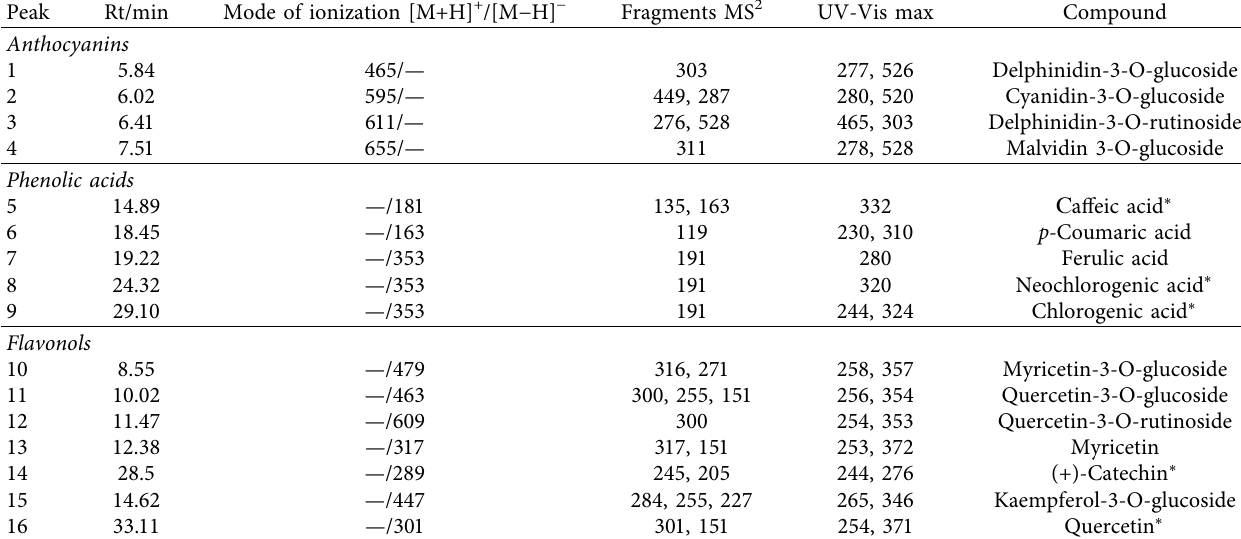
Table 3: Characterization of the main compounds of the black currant pomace extract using their spectral characteristic in HPLC-DAD. Peak Rt/min Mode of ionization [M+H] + /[M − H] − Fragments MS 2 UV-Vis max Compound Anthocyanins